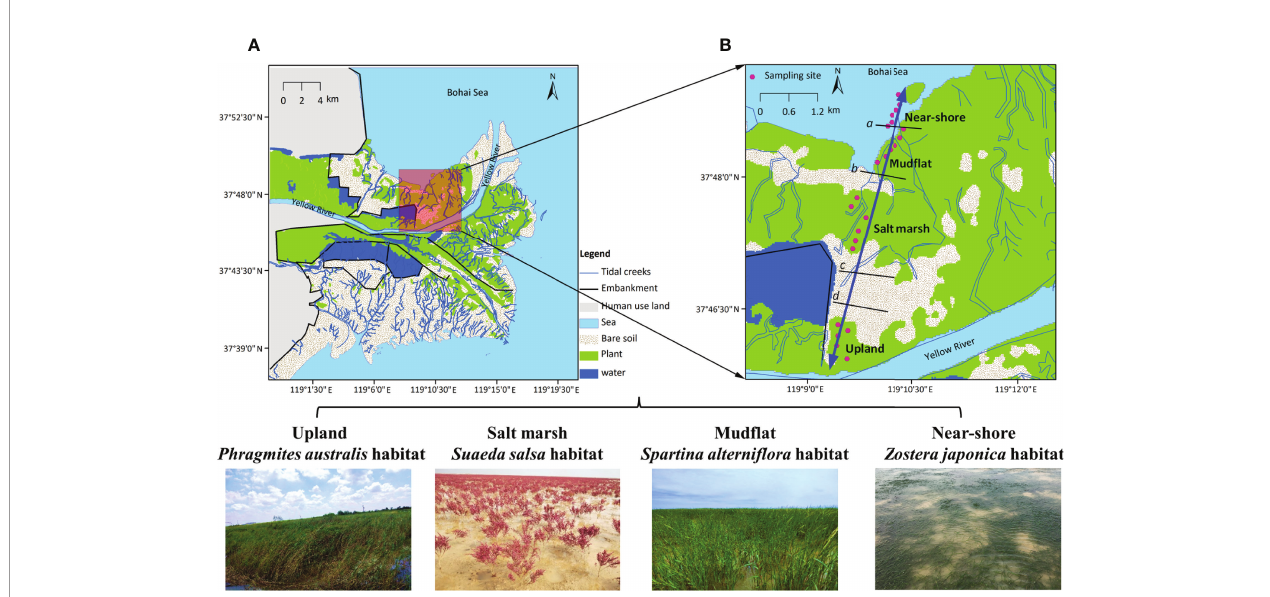
FIGURE 1 | (A) Map of China ’ s Yellow River Delta based on the interpretation of remote sensing images from 2015. (B) Location of the four studied vegetated habitats along a topographic gradient: Phragmites australis habitat in the upland, Suaeda salsa habitat in the salt marsh, Spartina alterni fl ora in the mud fl at, and Zostera japonica seagrass habitat in the near-shore waters. The black lines represent the approximate borders between adjacent habitats; thus, the lines marked with c and d represent the borders between the marsh and the terrestrial border and between the terrestrial border and the upland habitat, which developed at the highest astronomical tide based on data from Cui et al. (2011) and Li et al. (2020). Photos were taken by X. Li in